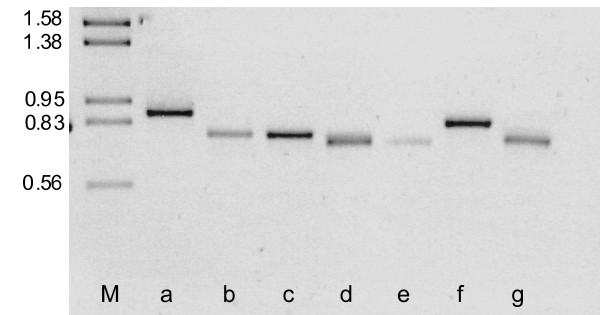
Tandem repeat region in the open reading frame ymf64 amplified from different Paramecium caudatum strains. DNA fragments from strains belonging to the same cox1 haplotype PcCOI_a03 [35] were separated on a 2.0% agarose gel. M, DNA size ladder in kb; lanes a-g, PCR amplified fragments from the different strains. Number of repeat units: (a) 18; (b) 11; (c) 11; (d) 9; (e) 9; (f) 14; (g) 10.